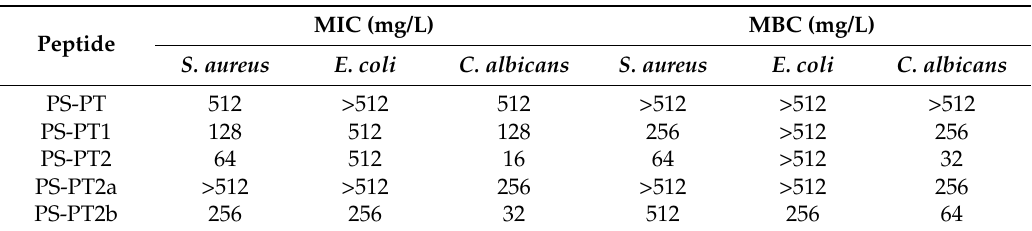
Table 2. Minimum inhibitory concentrations (MICs) and minimum bactericidal concentrations (MBCs) of PS-PT and its derivatives as determined for specified microorganisms.